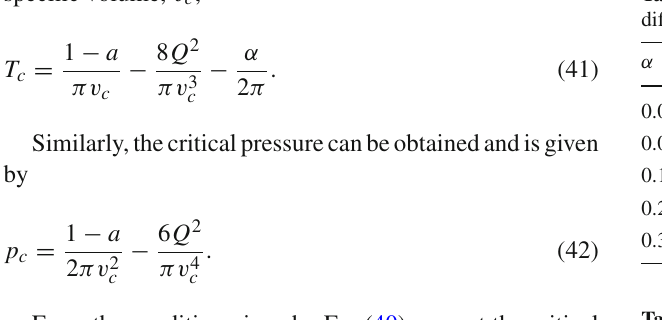
Table 3 Behaviour of the critical parameters v c , T c , p c e p c v c